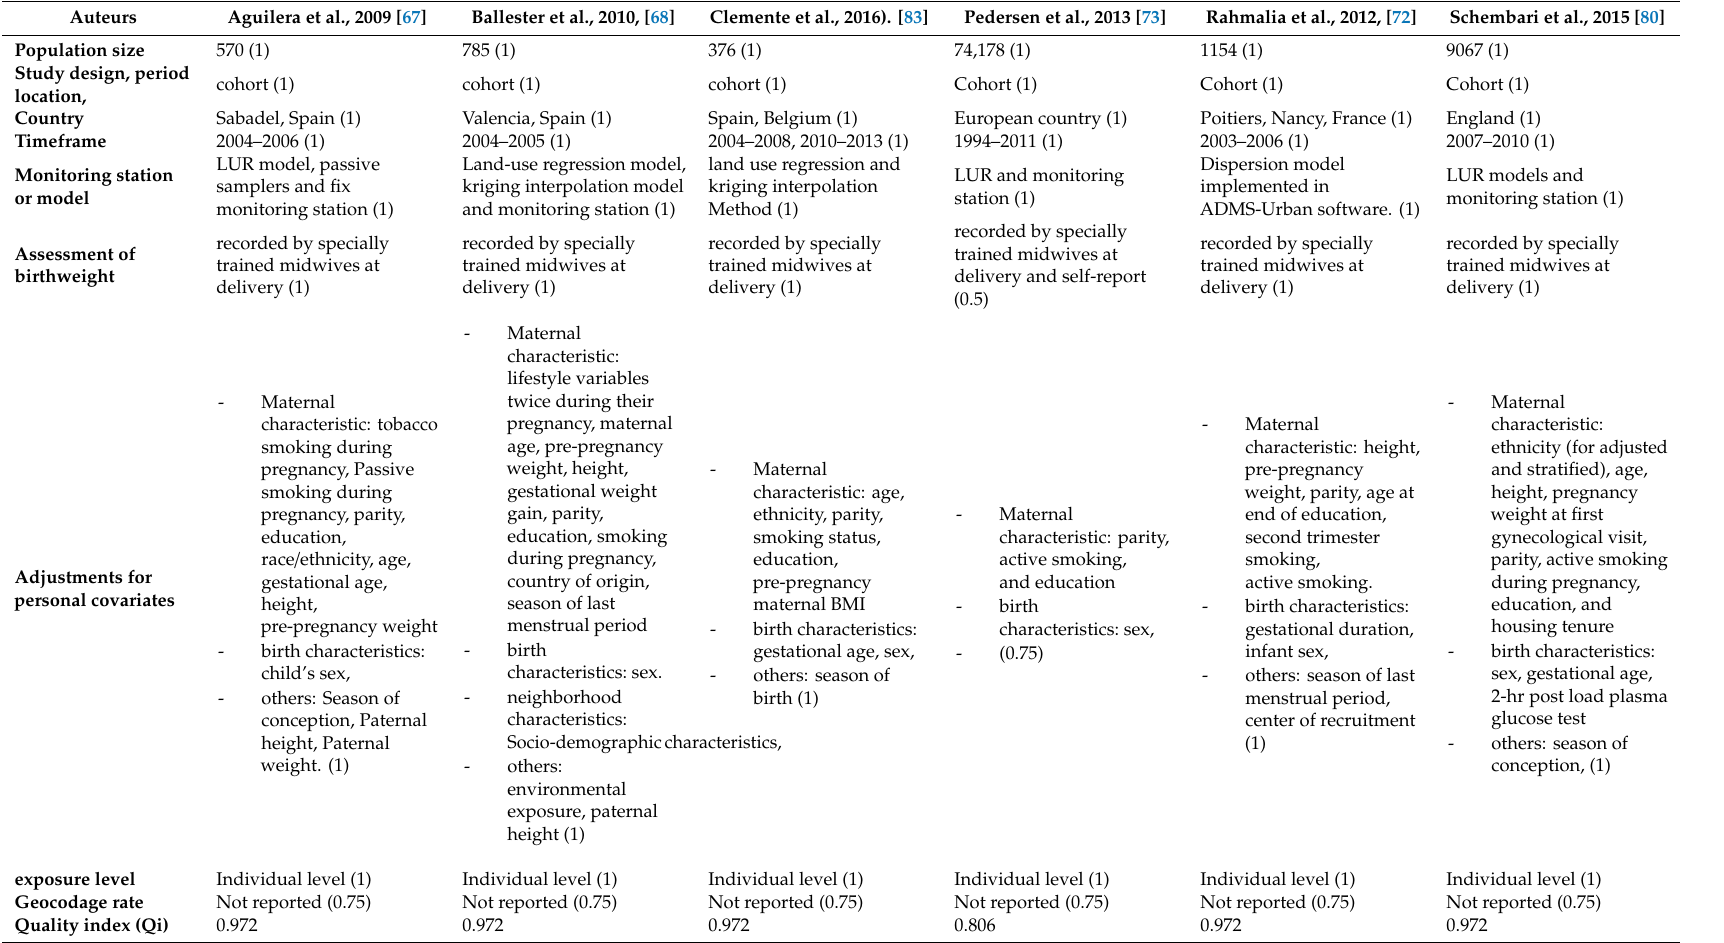
Table A3. Qualitative analysis (part